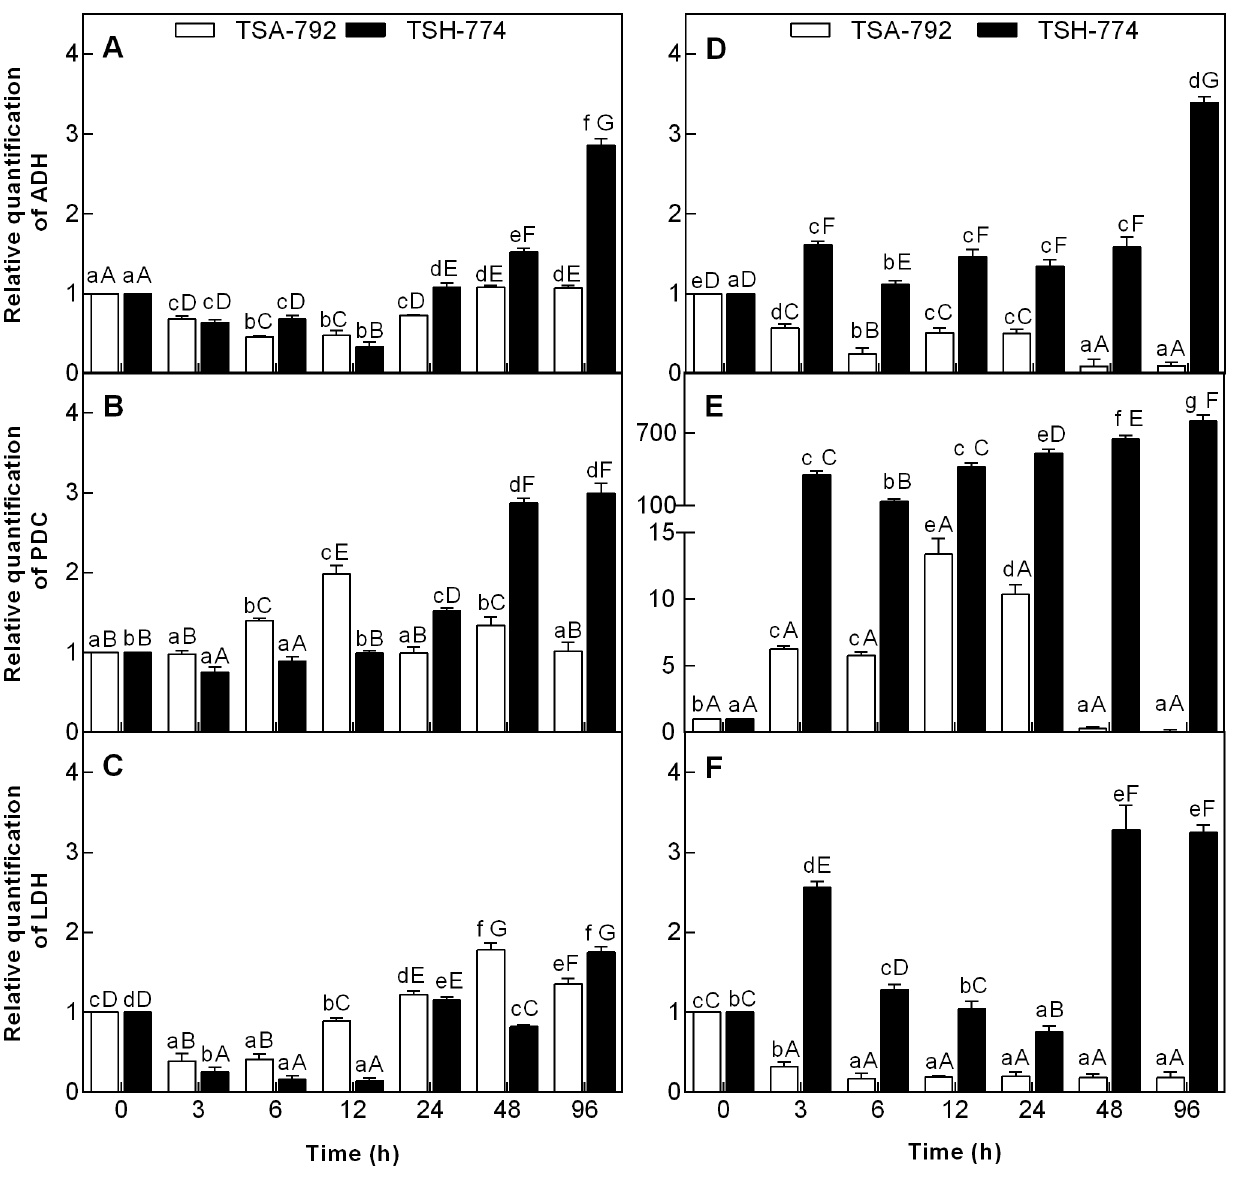
Figure 1. Relative quantity of transcripts encoded by the gene enzymes ADH (A and D), PDC (B and E) and LDH (C and F) quantified by qPCR and normalized by b -tubulin transcripts. The expressed values are relative to the responses of control leaves (A, B and C) and roots (D, E and F) as compared with those of flooded plants in two clonal genotypes of Theobroma cacao , (TSA-792 and 774-TSH). The columns represent the mean values 6 SE (standard error) of six biological replicates. Uppercase letters compare differences between genotypes and lowercase letters compare differences within genotypes. Mean comparisons were using a Tukey test (P , 0.05).